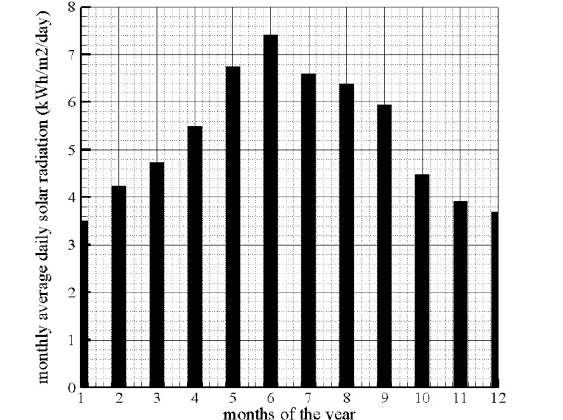
Figure 3. monthly average daily solar